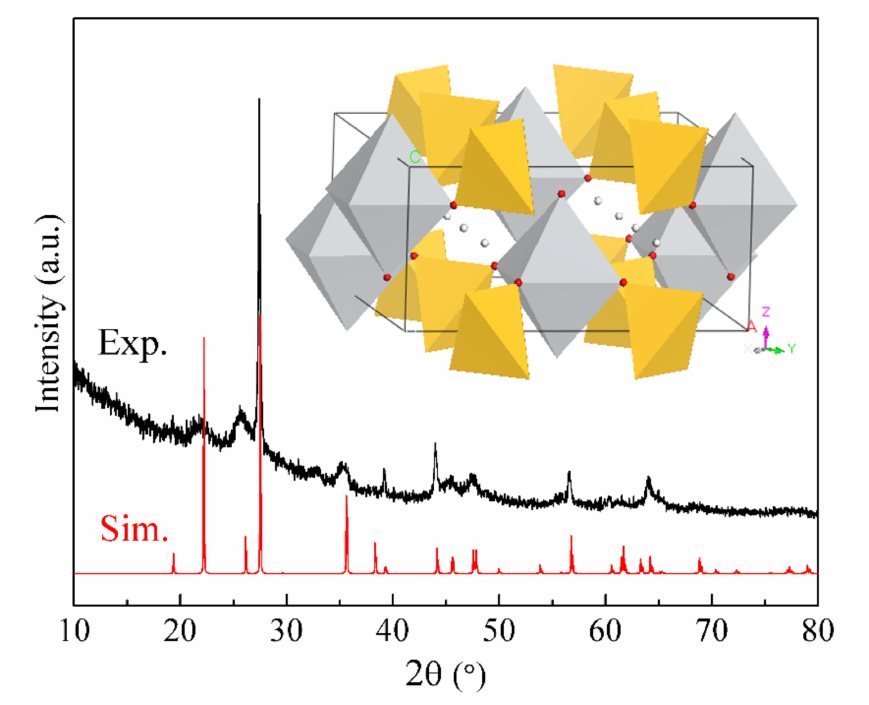
Figure 7. Experimental and simulated XRD patterns of the sample (A4) from washing natisite with sulfuric acid solutions (inset: a possible intermediate structure after Na + in natisite exchanging with H +